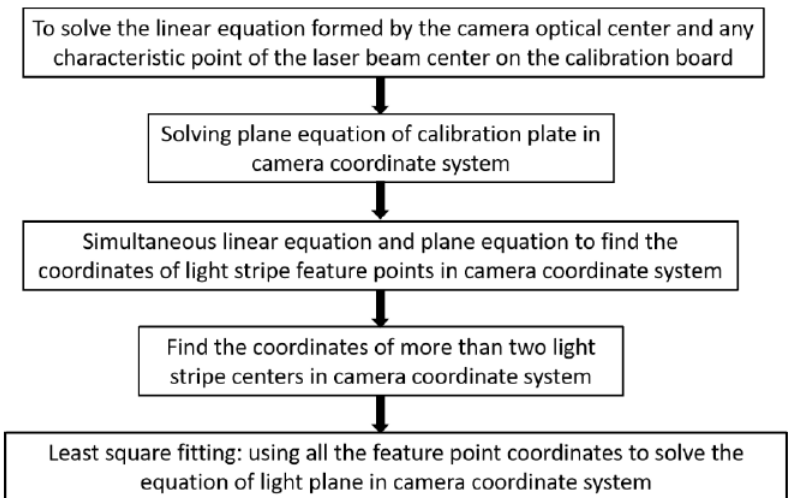
Figure 3. Flow chart of laser plane equation